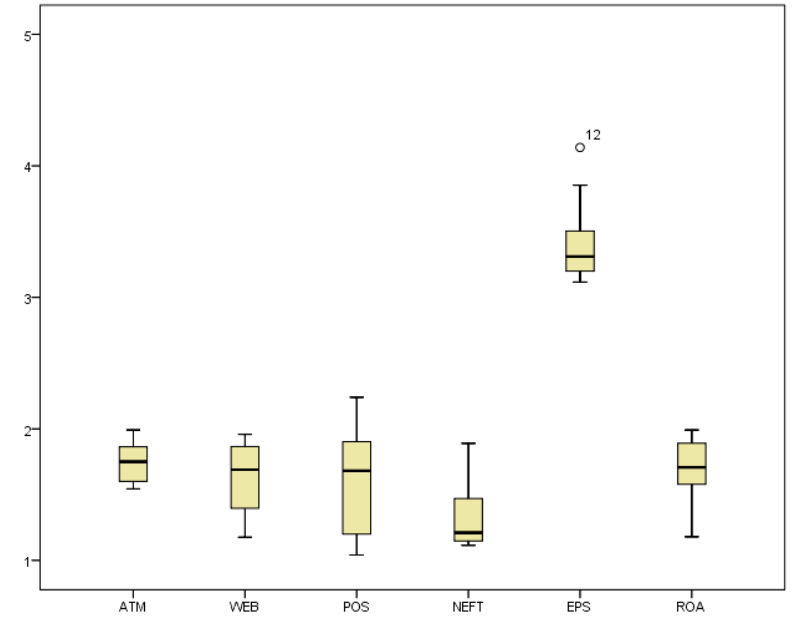
Figure 3. Box plot showing outliers for variables in this study